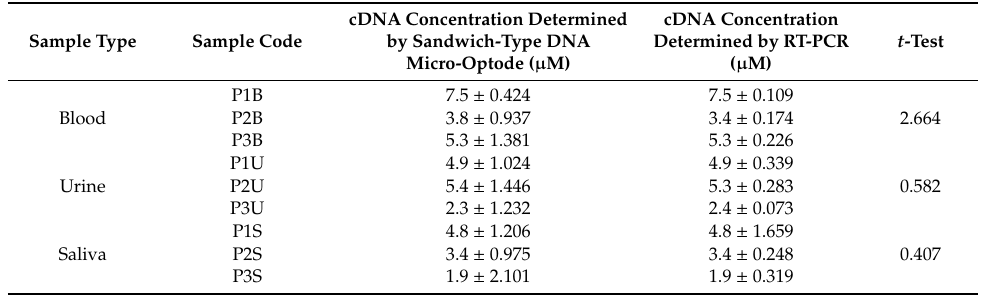
Table 2. Statistical comparison of two data sets on cDNA concentration determined by reflectance DNA biosensor and RT-PCR reference method by using paired t -test at 4 degrees of freedom and 95% confidence